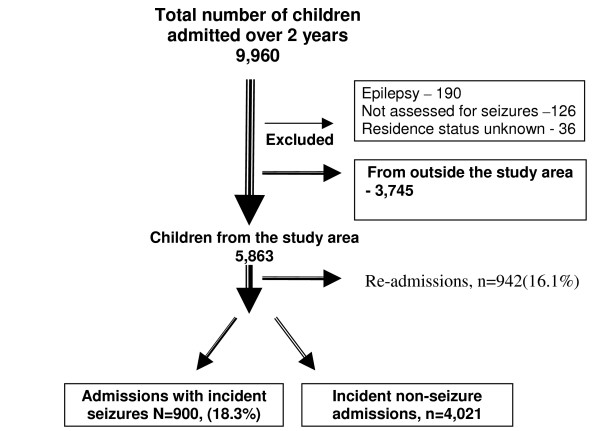
Admissions to KDH, December 2004 to November 2006.